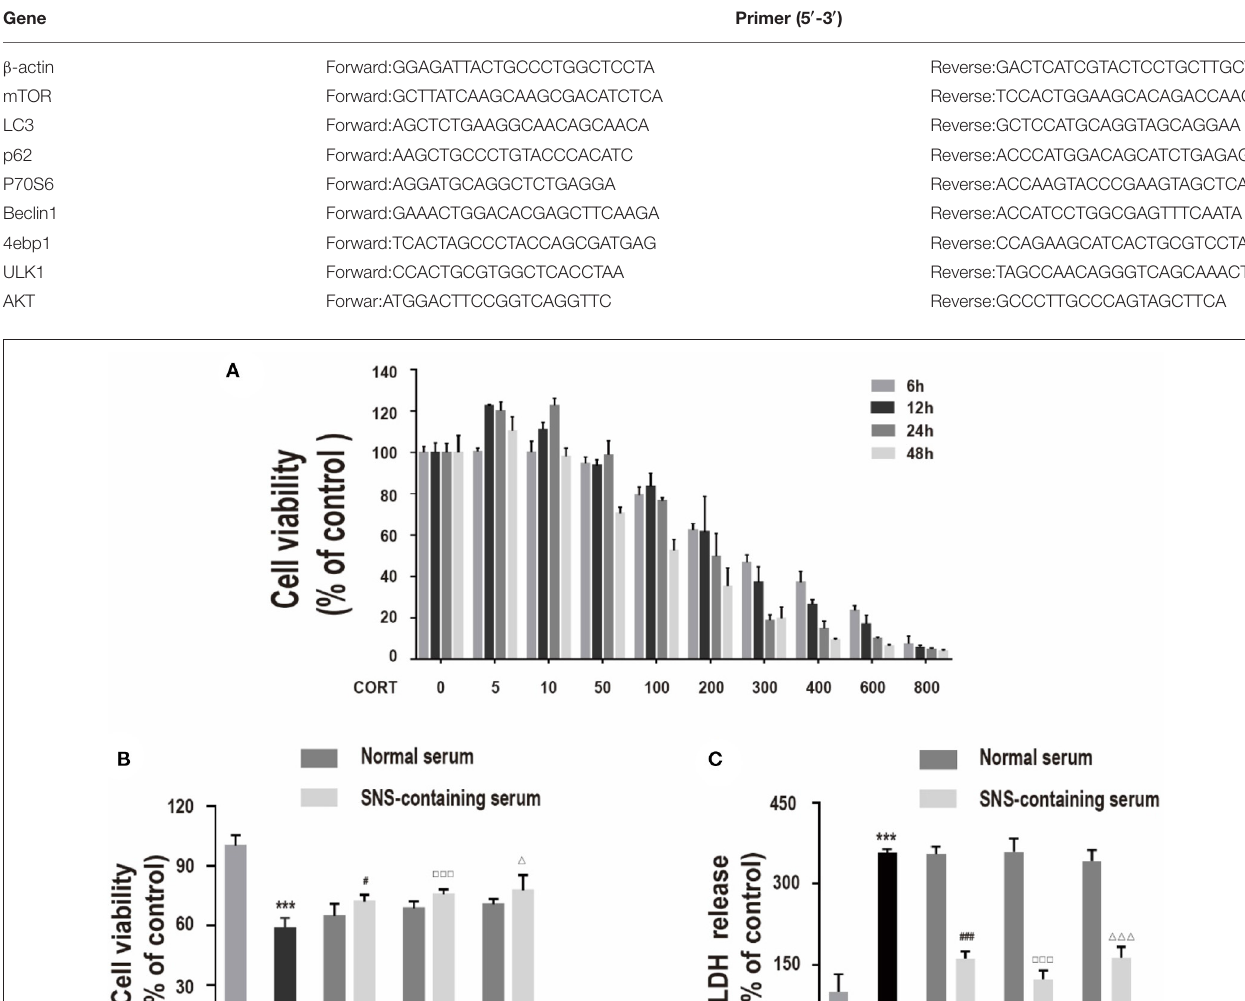
TABLE 1 | Sequences of qRT-PCR primers used.